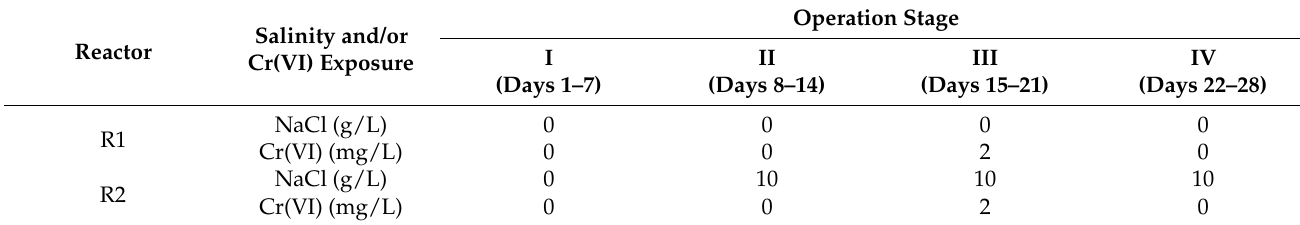
Table 1. The 4 operation stages for the two SBRs in this